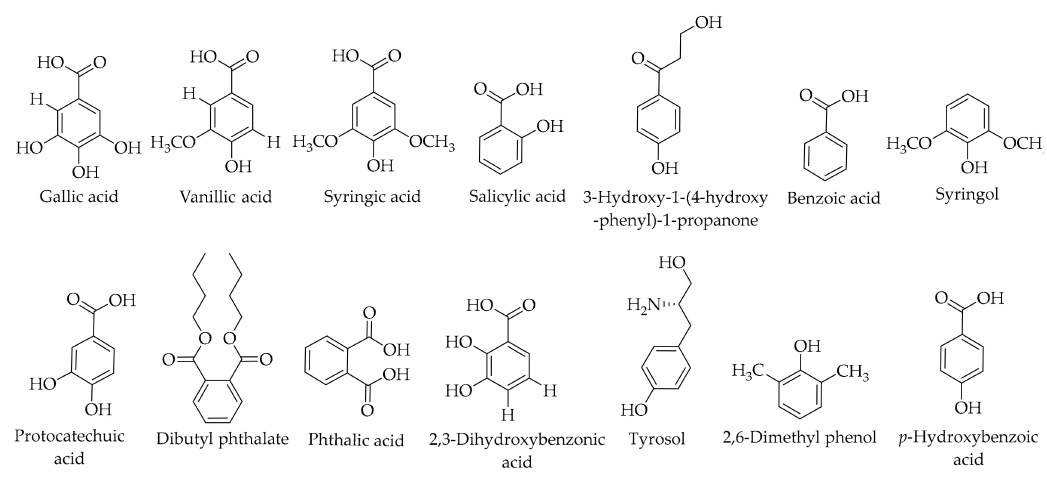
Figure 8. The chemical structures of di ff erent identified, isolated, and quantified hydroxybenzoic acids in the walnut green husk.